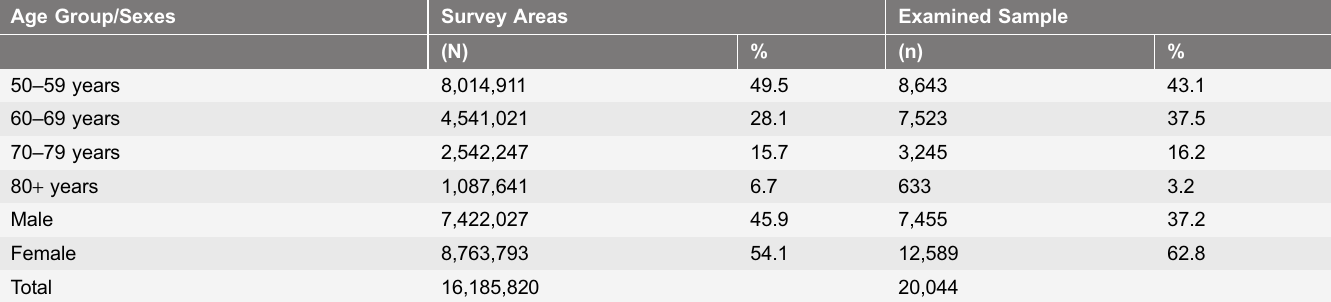
Table 2. Composition of population in sample and in survey area, by age and sex.